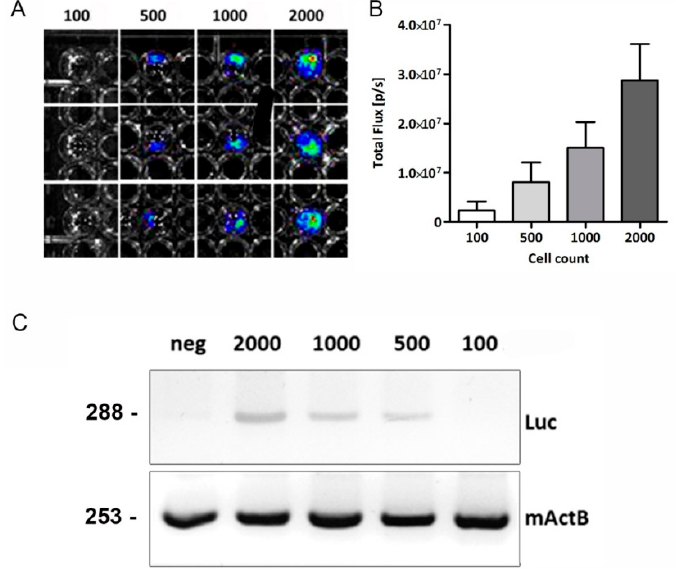
Figure 2. In vitro evaluation of Luc + -mASCs. ( A ) Bioluminescence signal of Luc + -mASCs after addition of D -Luciferin in culture (in triplicate: 100, 500, 1000, and 2000 cells). ( B ) Quantification of the bioluminescence signal (Photons/s) in relation to the total number of cells ( n = 6). ( C ) Sensitivity of conventional PCR, amplified with specific primer for luciferase and murine β -actin (mActB) as a housekeeping gene. Determination of the detection limit of luciferase RNA using PCR and several dilutions of RNA transcripts (Neg = RNA from 100,000 Luc - -mASCs, and dilutions: 2000 Luc + -mASCs + 98,000 Luc - -mASCs; 1000 Luc + -mASCs + 99,000 Luc - -mASCs).